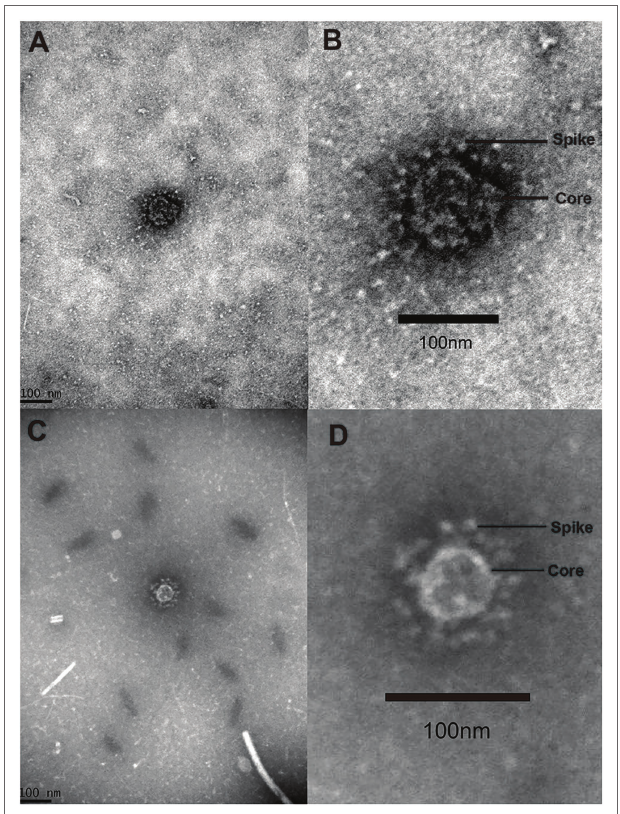
FIGURE 8 | Virion. Negative stained ToV-like particles. (A) The low magnification TEM image of particle A; (B) the high magnification TEM image of particle A; (C) the low magnification TEM image of particle B; (D) the high magnification TEM image of particle B.